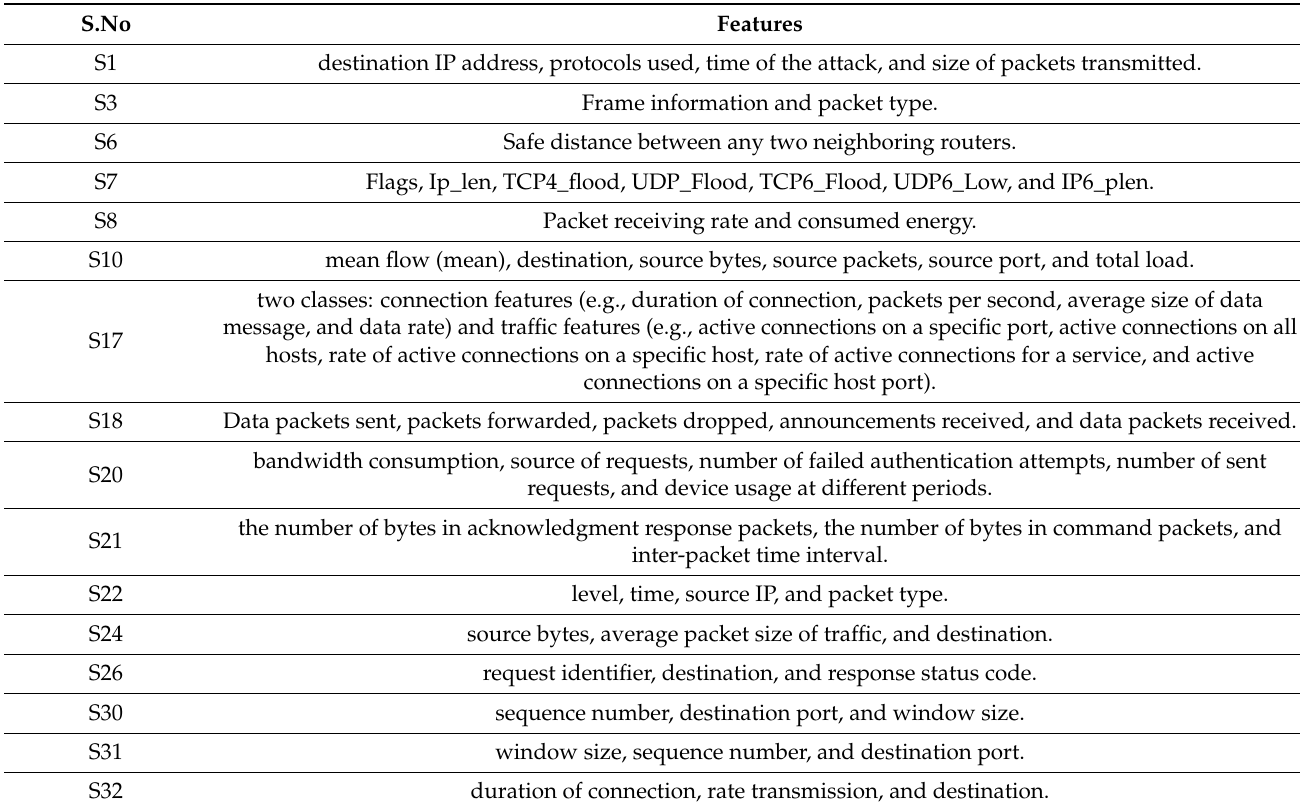
Table 11. Features considered in primary studies (IoT device testbed